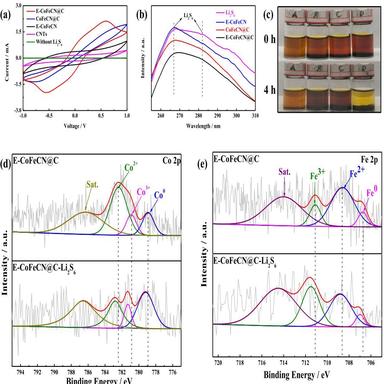
(a) CV curves of symmetric electrode of E-CoFeCN@C, CoFeCN@C, E-CoFeCN and CNTs with a similar specific surface area to E-CoFeCN@C; (b) the UV–vis spectra of Li2S6 solution add E-CoFeCN@C, CoFeCN@C, E-CoFeCN and blank respectively after 4 h; (c) the photos of bottles A-D: in turns of L2S6 solution, E-CoFeCN@C, CoFeCN@C and E-CoFeCN in L2S6 before and after 4 h; XPS spectra of E-CoFeCN@C before and after adsorb L2S6 (d) Co 2p and (e) Fe 2p.